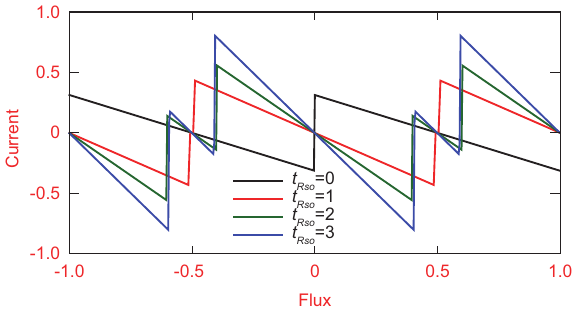
Figure 19 Current-fl ux characteristics of an 80-site ordered ( W = 0) half-fi lled ring for different values of t